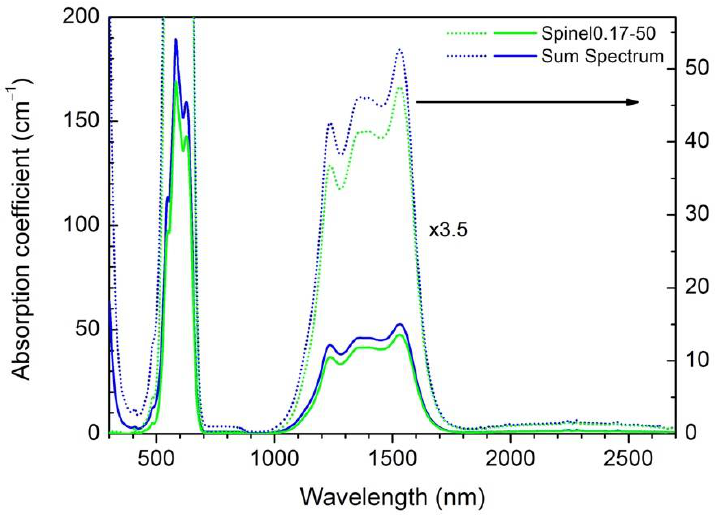
Figure 7. Sum spectrum (blue curve) calculated as the volume fraction × N Co weighted sum of MgO:Co and MgAl 2 O 4 :Co absorption cross-section spectra, as to represent absorption of sample Co0.48-750. The green line is the absorption coefficient of the single crystal Spinel0.17-50. The dotted lines show the spectra magnified × 3.5.